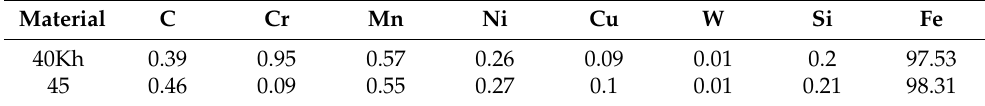
Table 1. Chemical composition of steels 40Kh and 45 (%).